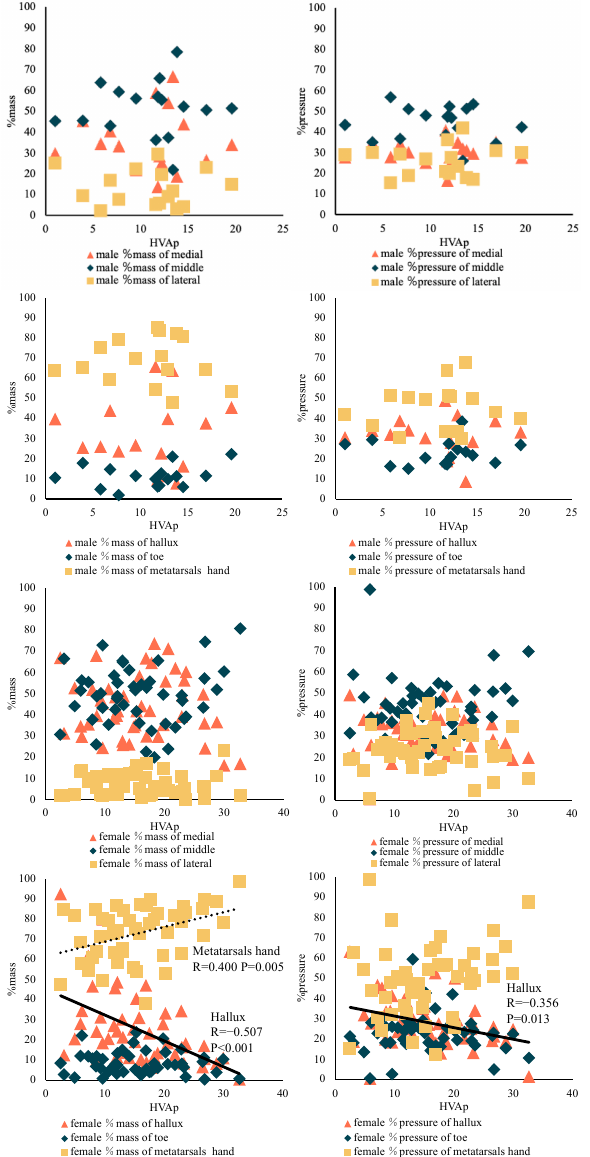
Figure 4. Relationship between the hallux angle and the %mass and %pressure impulse in male and female DanceSport athletes.